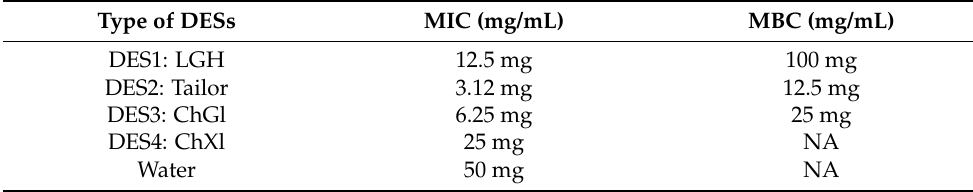
Table 3. The MIC and MBC activity of R. officinalis extracts.